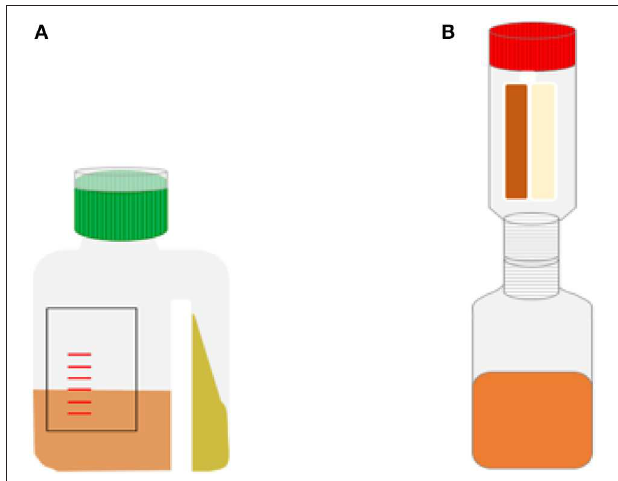
FIGURE 6 | Schematic representations of special biphasic bottle designs. (A) bottle used in study by Weckbach et al. ( 131). (B) Septi-Chek